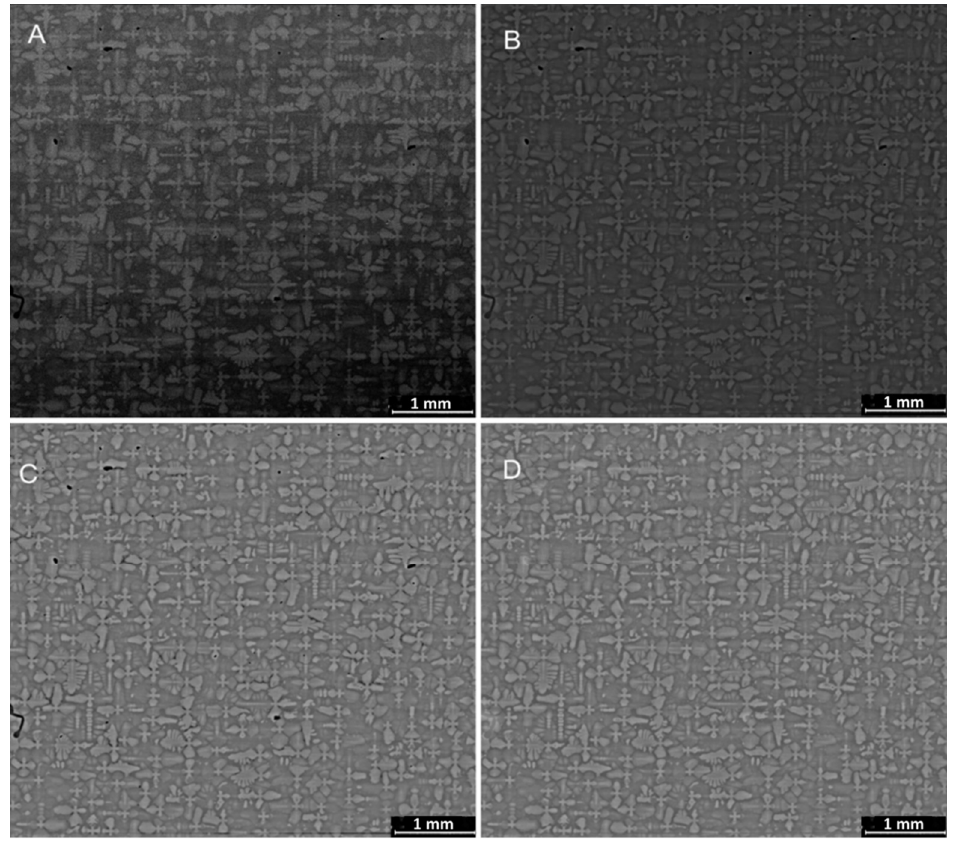
Figure 9. Images at each image processing step: ( A ) the input SEM image (CMSX-4 ® ) sectioned perpendicular to the long axes of the sample aligned with heat flow during solidification, ( B ) FFTBPF processed image, ( C ) image after histogram equalisation, and ( D ) image after black spots and noise removal.